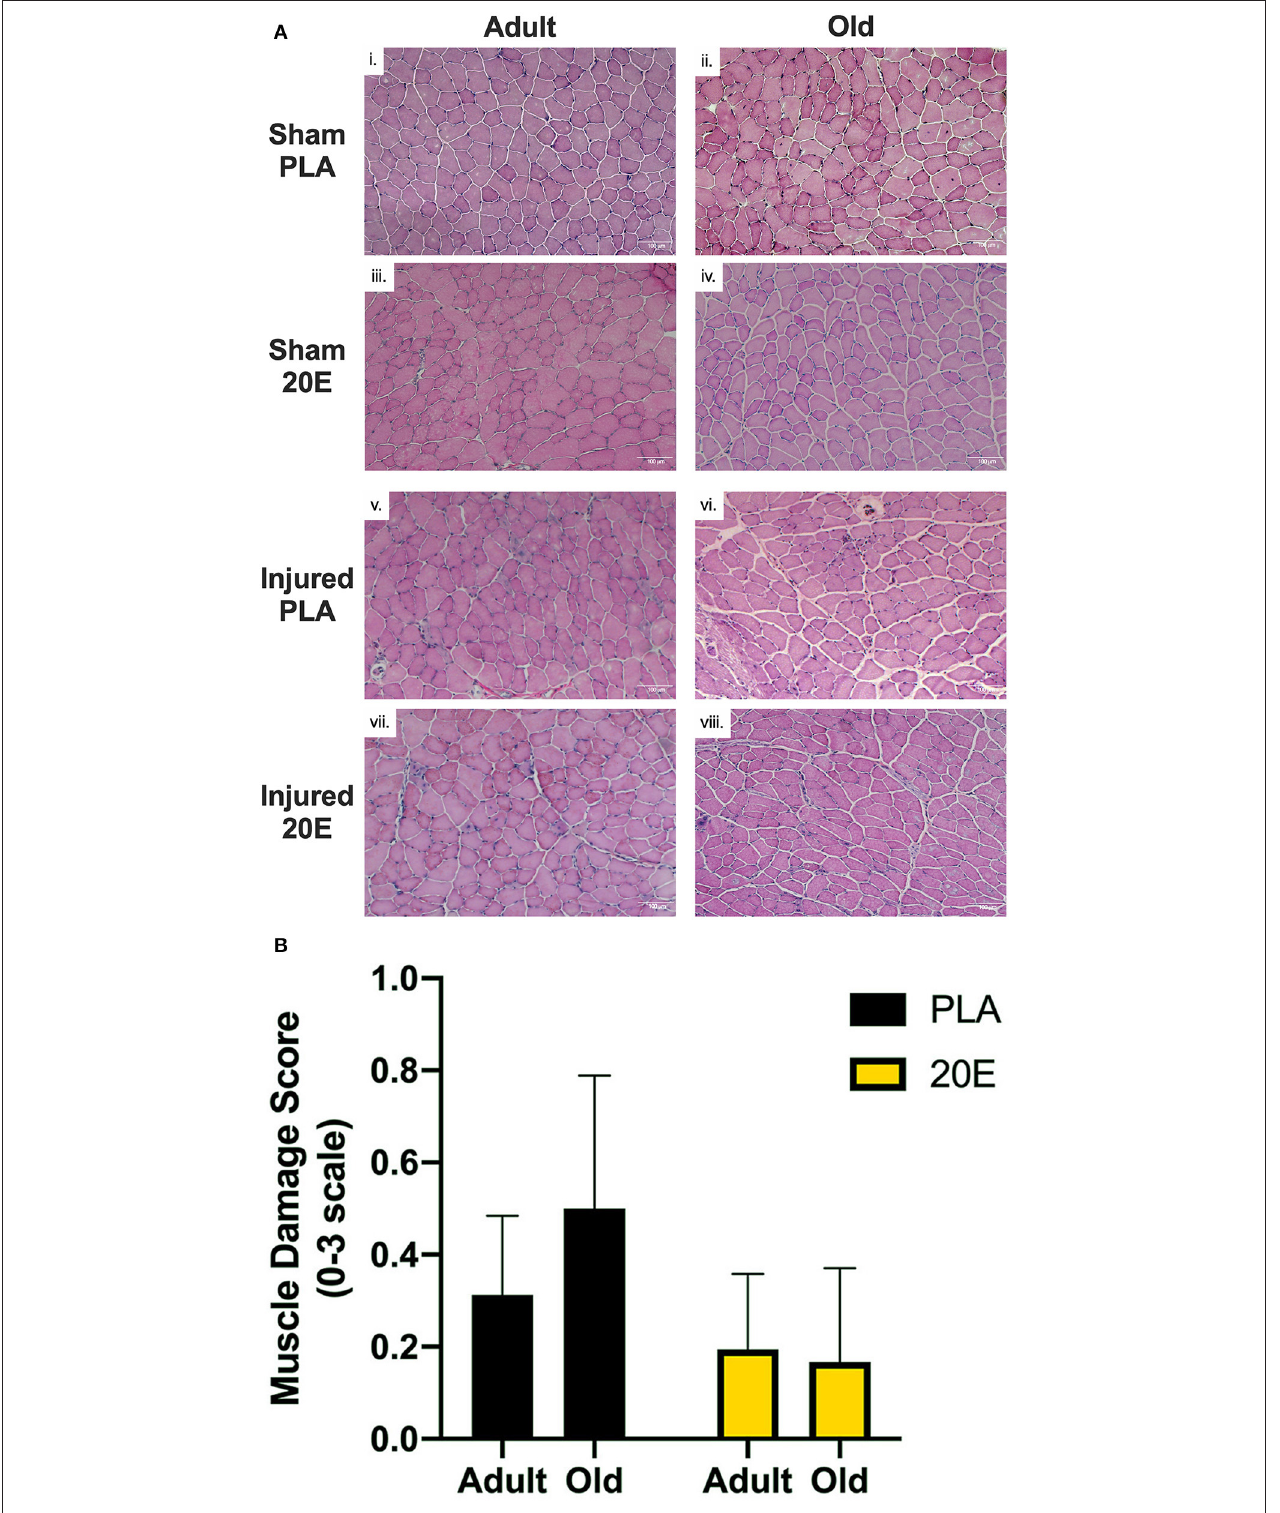
FIGURE 4 | Representative images for H&E-stained tibialis anterior (TA) muscle sections from sham-treated (Sham; i–iv) and eccentric damaged (Injured; v–viii) groups after the 7-day recovery period (A) and muscle damage scores of injured TA muscle sections (B) . H&E staining procedures provide visualization of the nuclei (dark blue) and cytosol (pink). (A) Injured TA muscle sections appear to have more markers of muscle damage (e.g., edema, overt fiber damage, presence of infiltrating inflammatory cells, and centrally-located myonuclei), regardless of treatment, compared to Sham muscle sections. (B) Qualitative analysis of